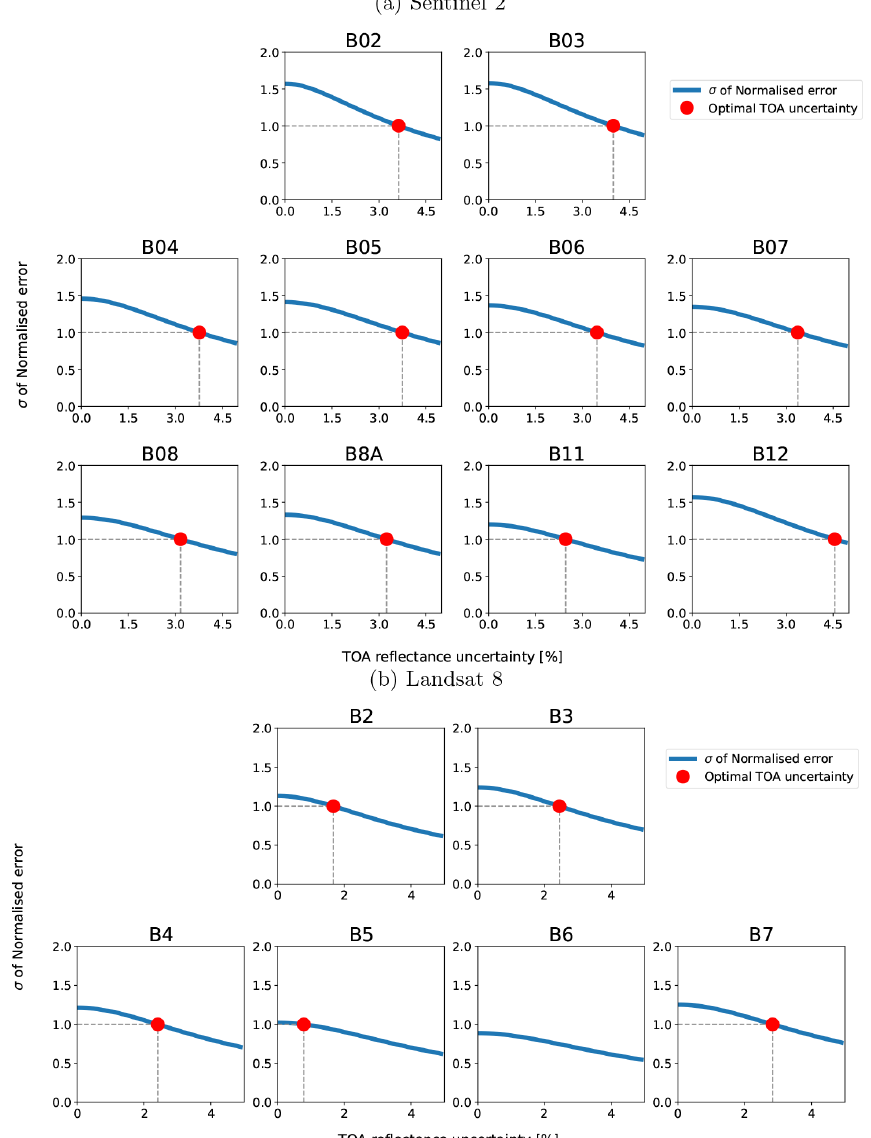
Figure H1. Surface reflectance normalised error distribution as a function of TOA reflectance uncertainty. The red dot indicates the point by changing the TOA uncertainty to reach the optimal uncertainty ( σ of 1 for the normalised error distribution). B6 for L8 in (b) has σ smaller than 1 for all the time and so cannot determine the optimal σ